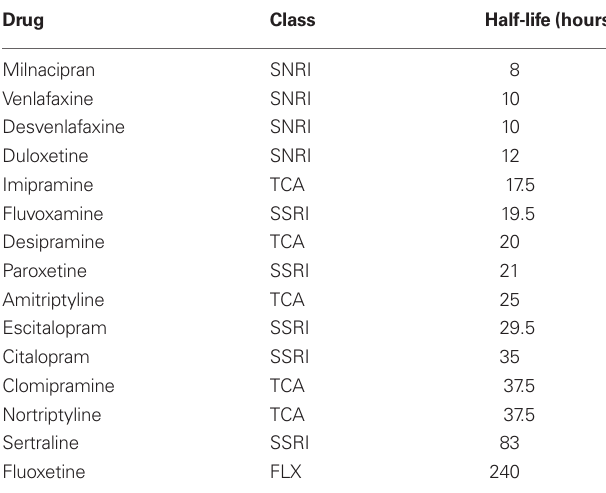
Table 2 | Half-lives of different antidepressant